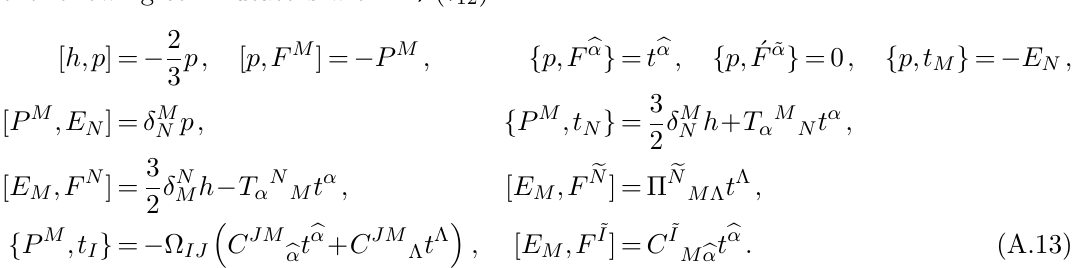
Table 6 . Decomposition of T ( e 12 ) generators under e 11 , with p table 3]. α is for adj cc and e Λ for L (Λ bb but we shall not use q = 1 2